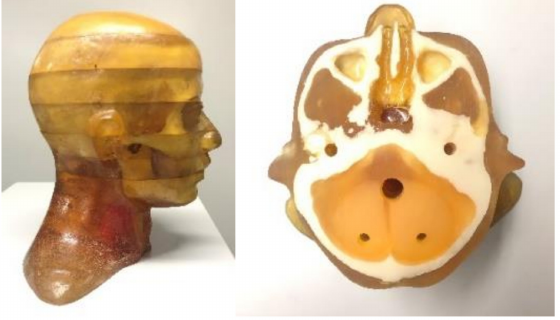
Figure 8. Real data experimental phantom: Chengdu dosimetric